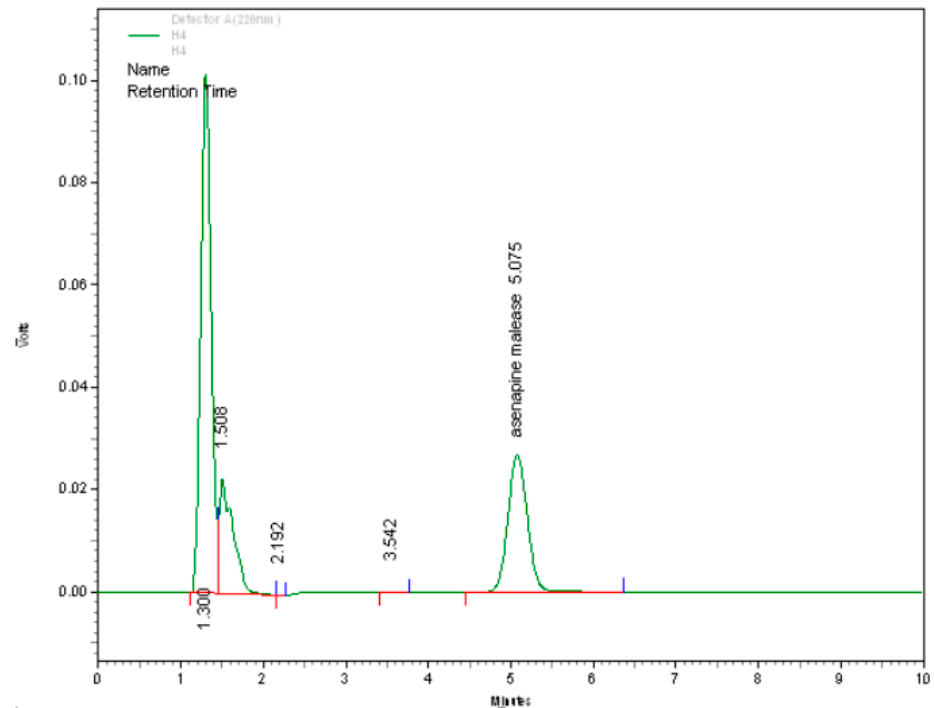
Figure 1. A chromatogram of the QC High sample of asenapine maleate (12 µg/mL). The green line is used to draw the chromatogram. The horizontal red line is used to integrate the peak area. The vertical red line indicates the start of the peak while the vertical blue indicates the end of the peak.